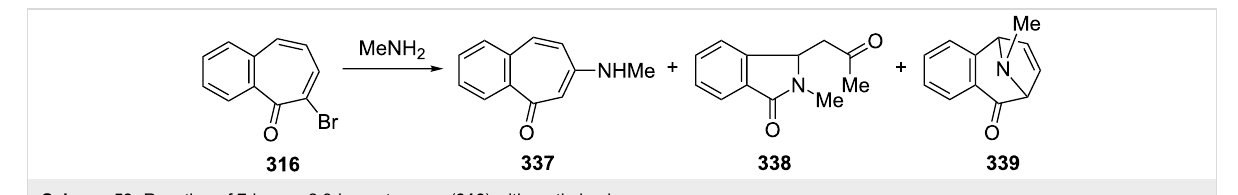
Scheme 59: Reaction of 7-bromo-2,3-benzotropone ( 316 ) with